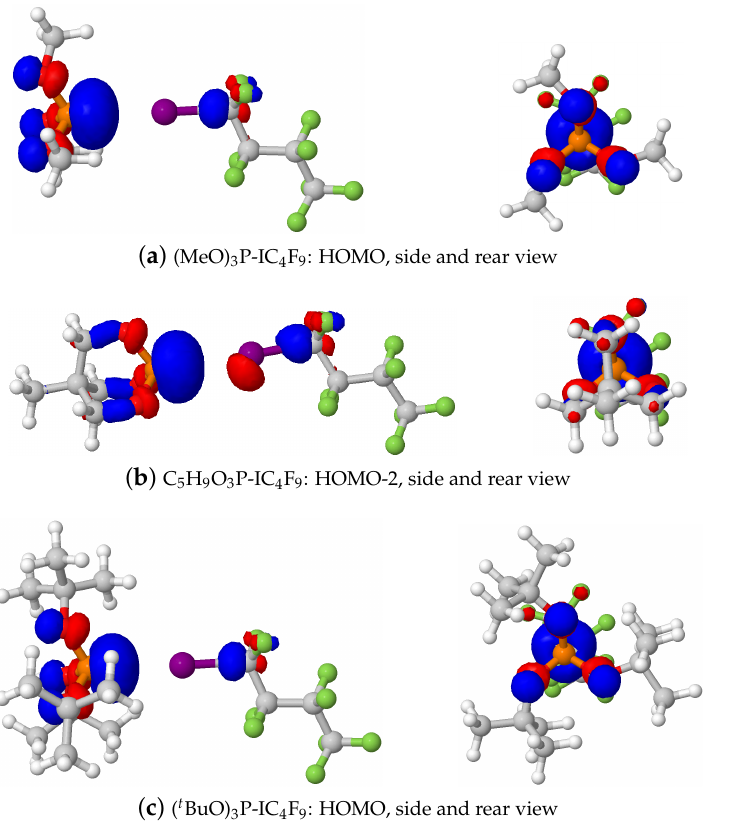
Figure 10. Frontier molecular orbitals of the phosphite–IC 4 F 9 adducts at the S 0